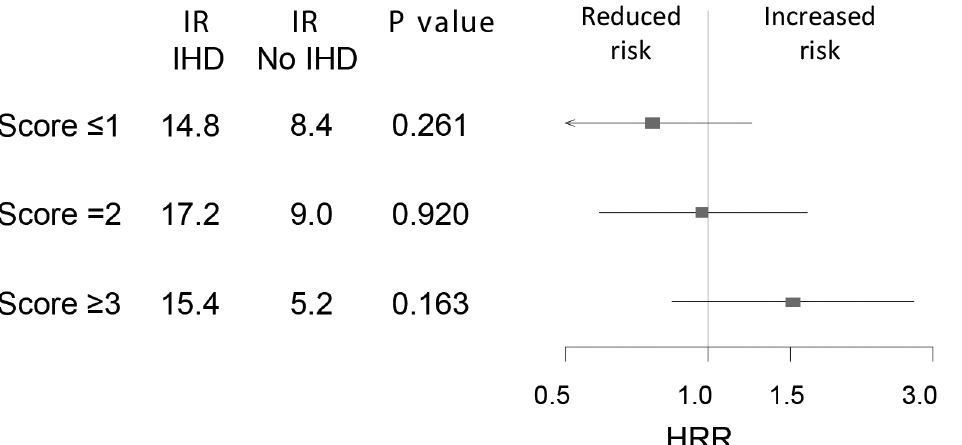
Fig 4. Difference in risk of cardiovascular death with different levels of genetic score A in angiotensin-converting enzyme inhibitor-treated patients with congestive heart failure (CHF) and ischemic heart disease (IHD) compared with no IHD. Results from adjusted multivariate Cox proportional hazard analyses. IR: Incidence rate per 100 patient-years; HRR: hazard rate ratio. Error bars illustrate 95% confidence